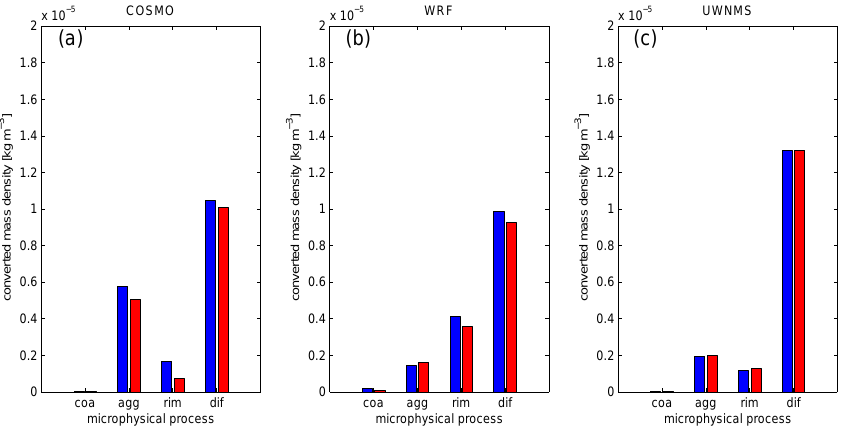
Fig. 12. Same as Fig. 10 but for the clean case simulation SIM 2 CC (blue) and the polluted case simulation SIM 2 PC (red), respectively. process are negligible in all models. Riming is decreased in COSMO and WRF but is slightly increased in